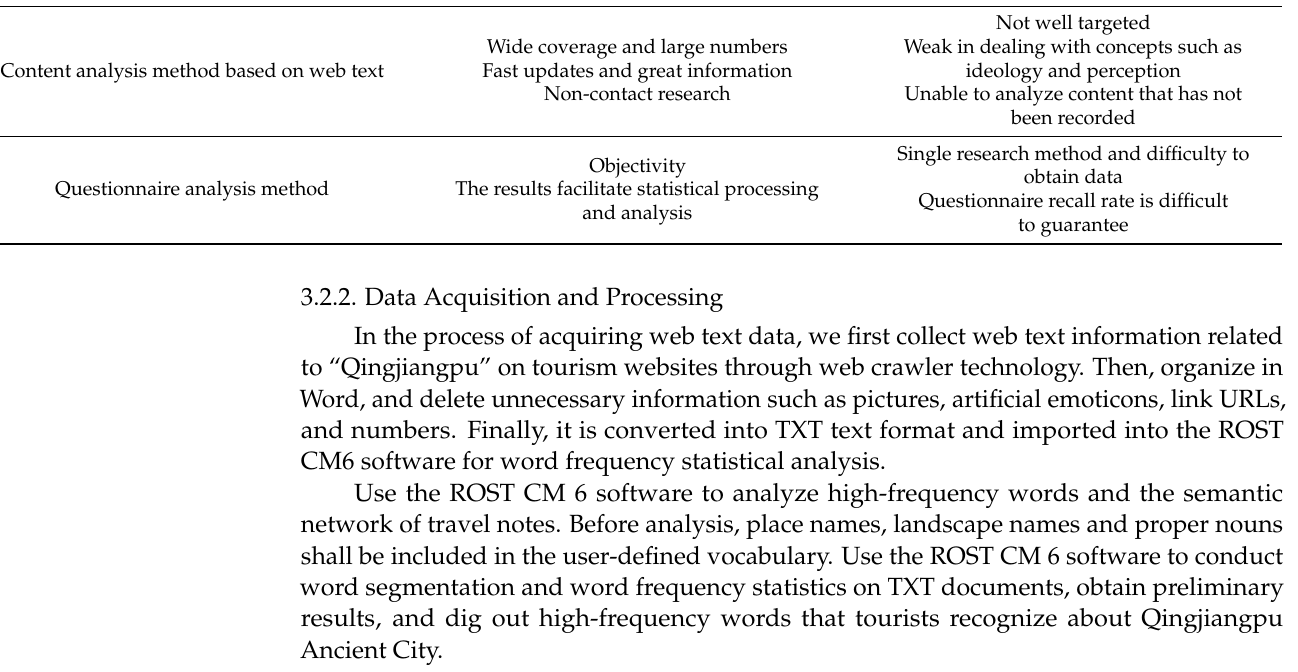
Table 1. Advantages and disadvantages of web text content analysis and questionnaire analysis. Analytical